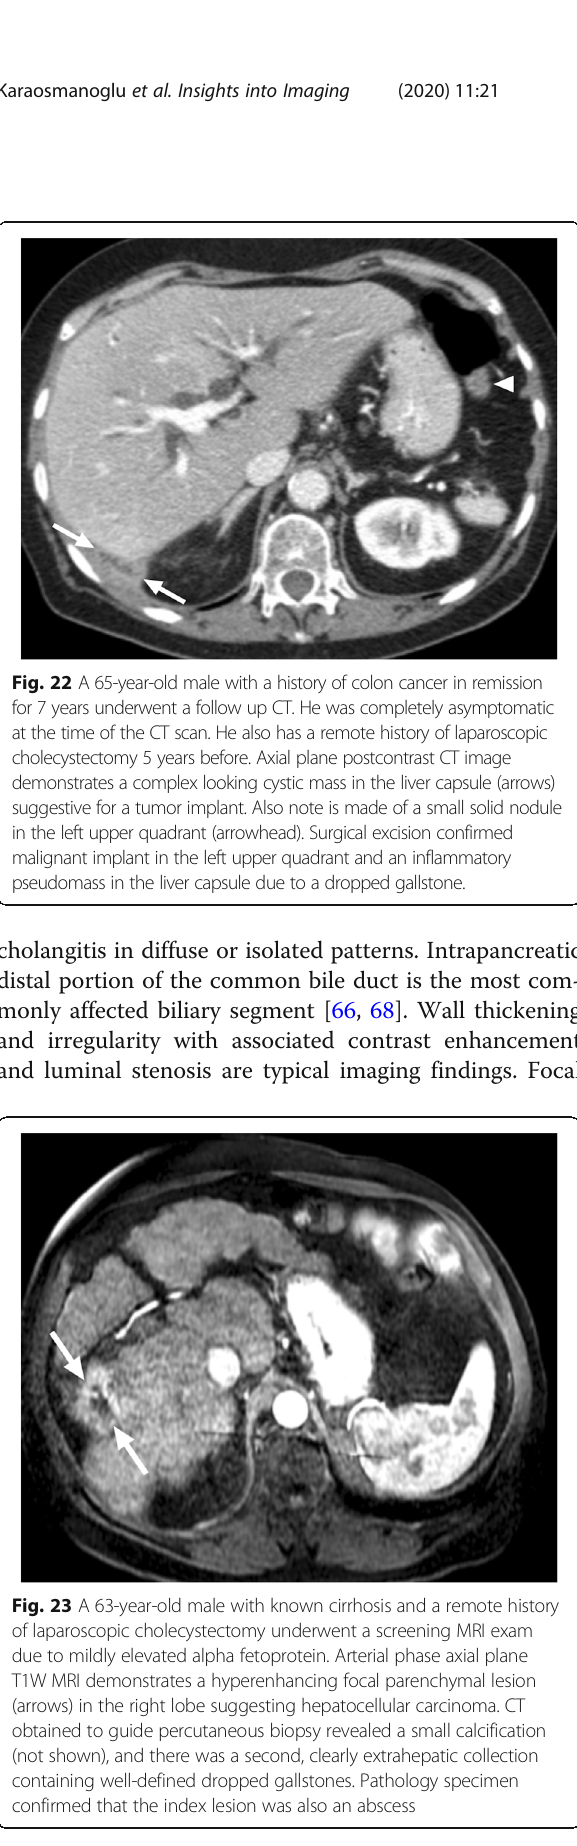
Fig. 23 A 63-year-old male with known cirrhosis and a remote history of laparoscopic cholecystectomy underwent a screening MRI exam due to mildly elevated alpha fetoprotein. Arterial phase axial plane T1W MRI demonstrates a hyperenhancing focal parenchymal lesion (arrows) in the right lobe suggesting hepatocellular carcinoma. CT obtained to guide percutaneous biopsy revealed a small calcification (not shown), and there was a second, clearly extrahepatic collection containing well-defined dropped gallstones. Pathology specimen confirmed that the index lesion was also an